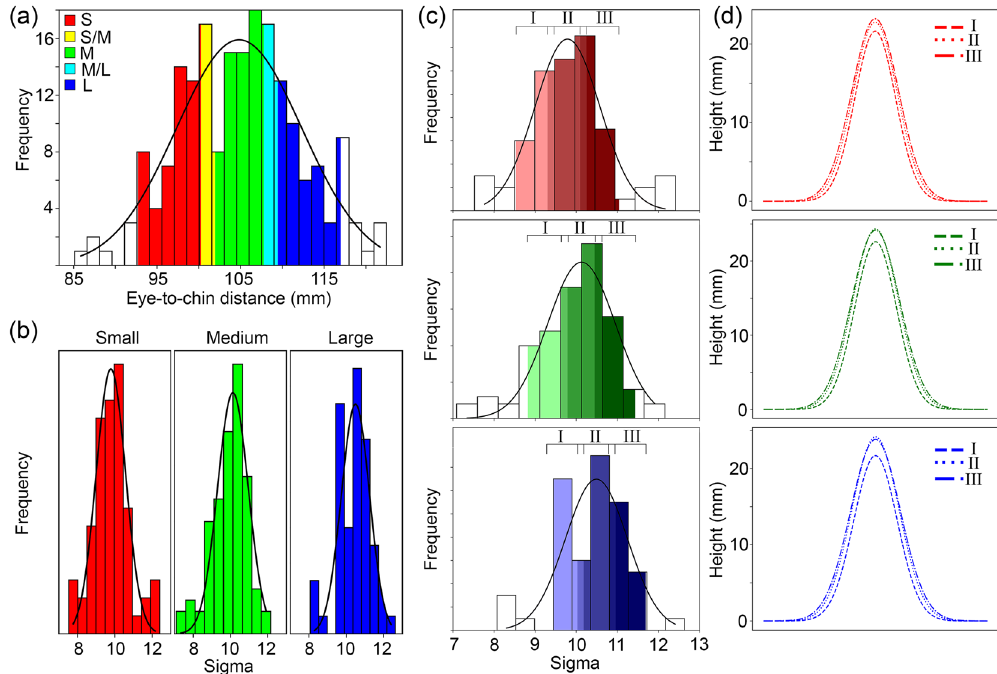
Figure 5. Graphs showing the extracted facial parameters from the sample cohort of 200 and subsequent determination of semi-customised designs. ( a ) Shows distribution of the eye-to-chin distance of the full 200 subjects with colour representing the different corresponding hard-shell sizes (S/M/L). ( b ) Shows the distribution of σ values for each hard-shell size and ( c ) shows the corresponding nasal profiles (I, II, III) for each. ( d ) Illustrates the nasal profiles established for each of the semi-customised